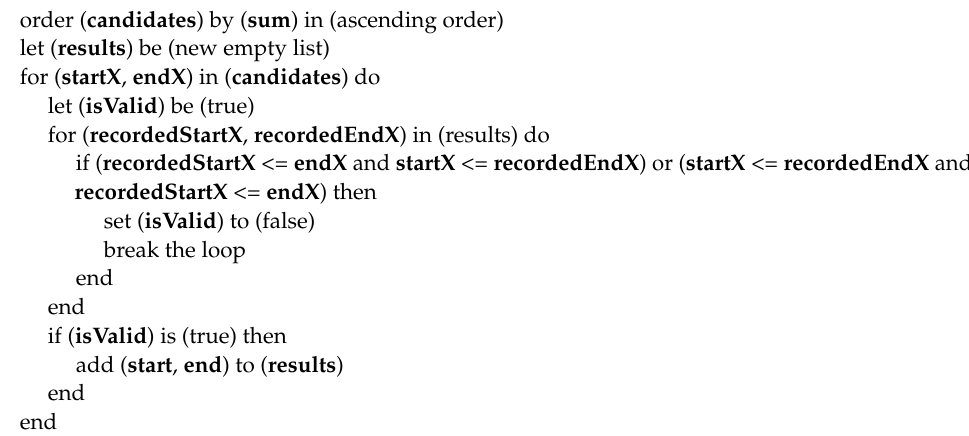
Algorithm 4: Pseudo code for the Graph Aligner module of the TSPDA.